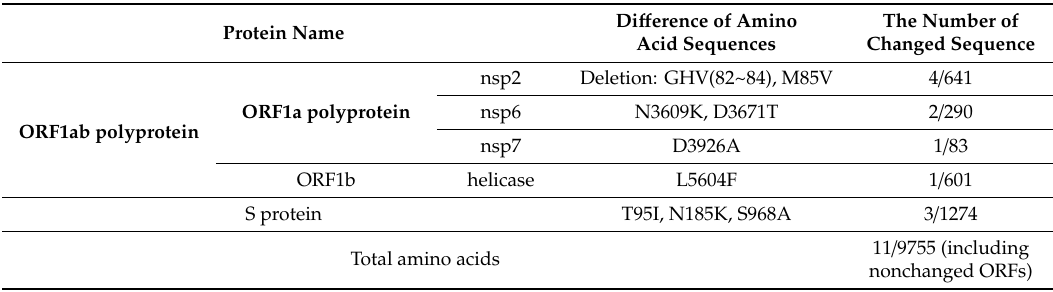
Table 1. Unique sequences of amino acids in cold-adapted live attenuated SARS-CoV-2 vaccine strain (SARS-CoV-2 / human / Korea / CNUHV03-CA22 ◦ C / 2020). Di ff erence of Amino The Number of Protein Name Acid Sequences Changed Sequence nsp2 Deletion: GHV(82~84), M85V 4 / 641 ORF1a polyprotein nsp6 N3609K, D3671T 2 / 290 ORF1ab polyprotein nsp7 D3926A 1 / 83 ORF1b helicase L5604F 1 / 601 S protein T95I, N185K, S968A 3 / 1274 11 / 9755 (including Total amino acids nonchanged ORFs) We compared the amino acid sequences of SARS-CoV-2 / human / Korea / CNUHV03-CA22 ◦ C / 2020 with those in GenBank (https: // www.ncbi.nlm.nih.gov / nuccore) and GISAID (https: // www.gisaid.org / ). We found out the unique amino acids in our cold-adapted live attenuated SARS-CoV-2 vaccine strain (SARS-CoV-2 / human / Korea / CNUHV03-CA22 ◦ C /